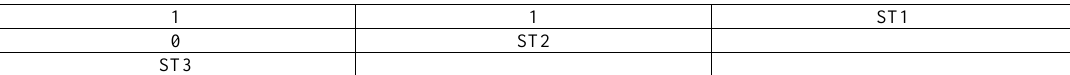
Table 2. Self-interaction binary matrix for situations in binary form.